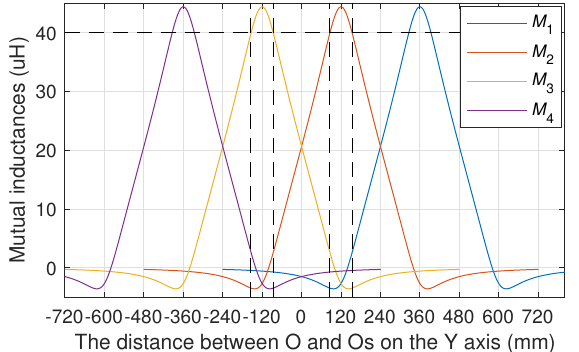
Figure 4. Simulation of the mutual inductance between the primary coil group and the secondary